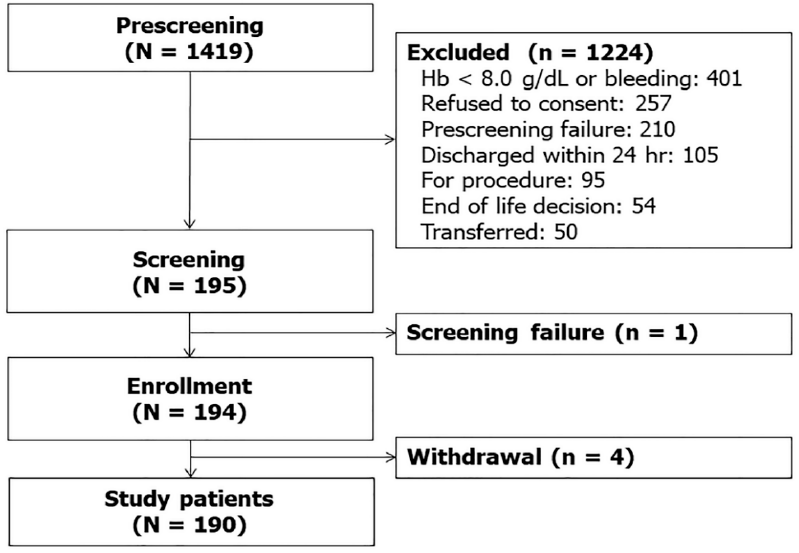
Figure 1. Study flow diagram.